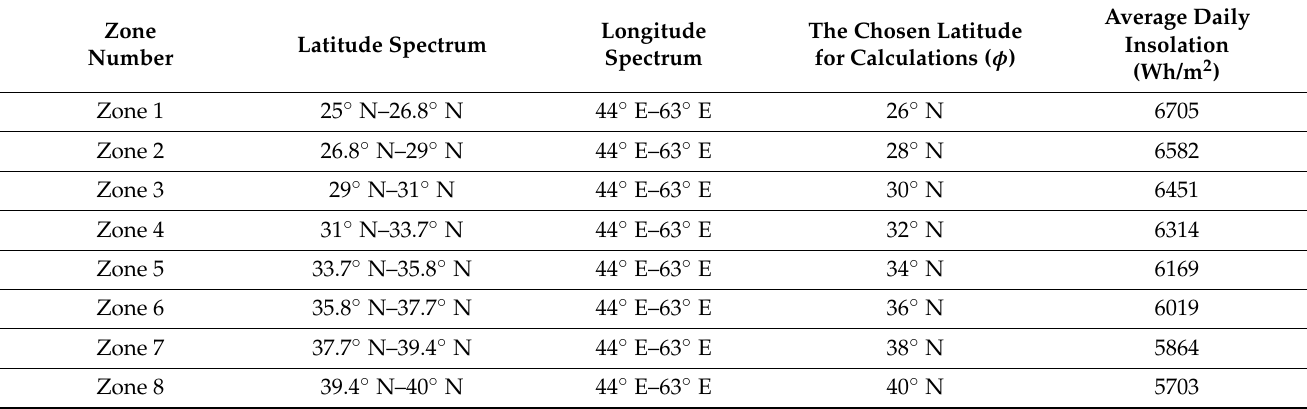
Table 3. Average daily insolation in the eight different